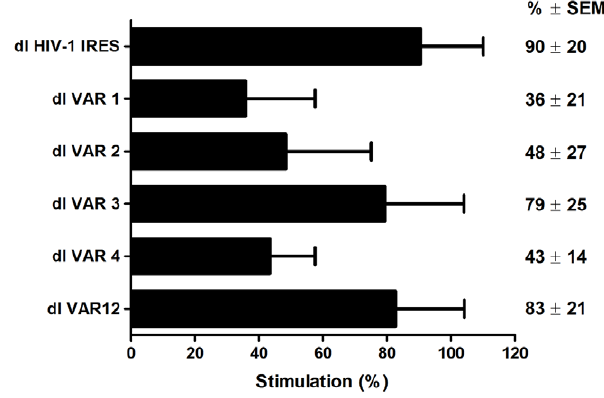
Figure 6. The hnRNPA1 protein enhances translation from the HIV-1 5 9 UTR. HeLa cells were transfected with either the plasmid expressing hnRNPA1 or the equivalent empty vector in combination with dl HIV-1 IRES or the different dl VAR vectors. Cells were processed and RLuc and FLuc activities were measured. The FLuc/RLuc ratio for each individual bicistronic vector in presence of the empty vector was arbitrary set as the base line. The increase in FLuc/RLuc ratio, which reflects the increase of HIV-1 IRES activity, in presence of the plasmid expressing hnRNPA1 for each individual bicistronic vector is graphed as percentage (%) of stimulation. Values are the means + /- SEM from three independent experiments.